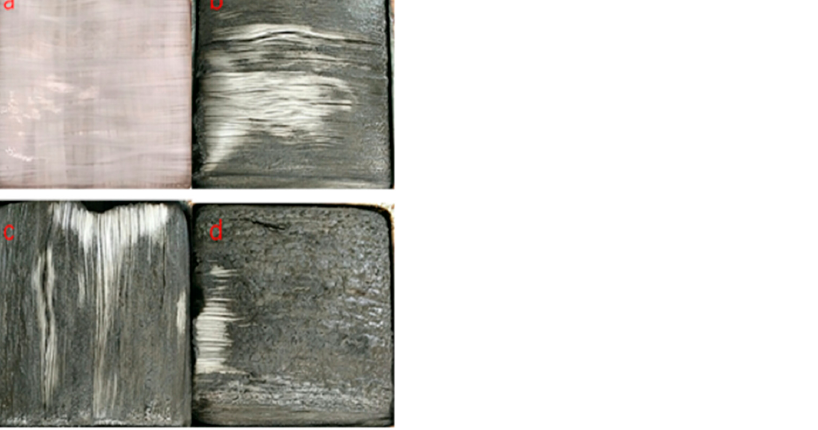
Figure 10. Side view digital photographs of residues after cone calorimeter testing, ( a ) CGF/PP ( b ) CGF/PP/20IFR/HPP ( c ) CGF/PP/25IFR/HPP ( d ) CGF/PP/30IFR/HPP.